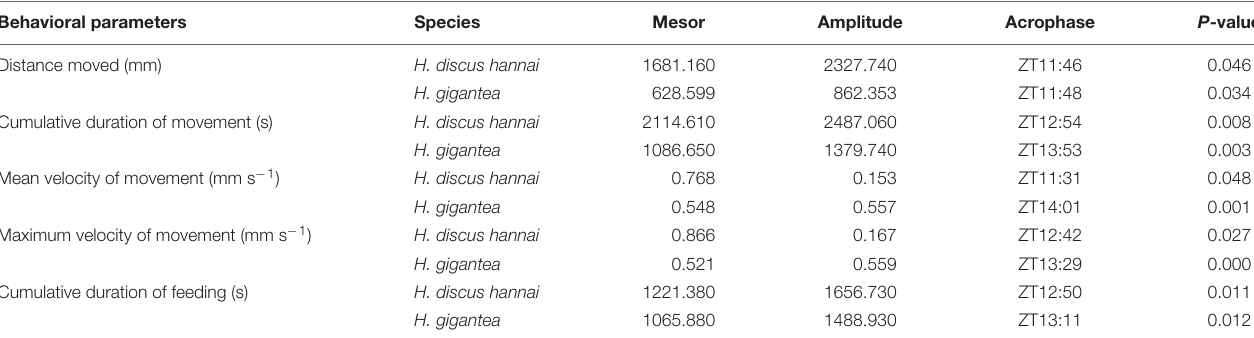
FIGURE 1 | Distance moved (A) , cumulative duration of movement (B) , mean velocity of movement (C) , and maximum velocity of movement (D) by Haliotis discus hannai and Haliotis gigantea . Values are expressed as mean ± SE, sample size = 30. Treatments with different letters are significantly different at different sampling times in the same species ( P < 0.05). “*” and “**” indicate significant differences ( P < 0.05 and P < 0.01, respectively) in movement parameters at the same sampling time in different species. No label indicates no significant difference ( P < 0.05) in movement parameters at the same sampling time in the same species. TABLE 2 | Cosinor analysis results obtained based on the behavioral